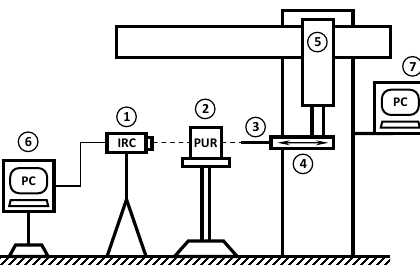
Figure 1. Experimental setup: 1—IR camera with connection to PC; 2—block of PUR foam; 3—drill; 4—dental drilling machine; 5—CNC milling machine with horizontal movement; 6 and 7—PC for